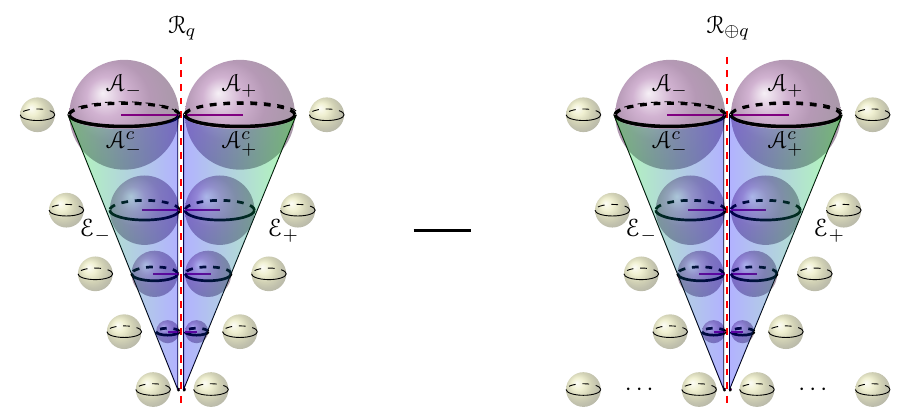
Figure 12 . The di(cid:11)erence between the manifolds R q and R (cid:8) q from the viewpoint of closed topo- logical string theory is localized at the tip of the codimension-two surface E in them, obtained by identifying the surfaces E (cid:0) and E + . At the tip, where radial coordinate r = 0, R q has only one S 2 , but R (cid:8) q has q -number of S 2